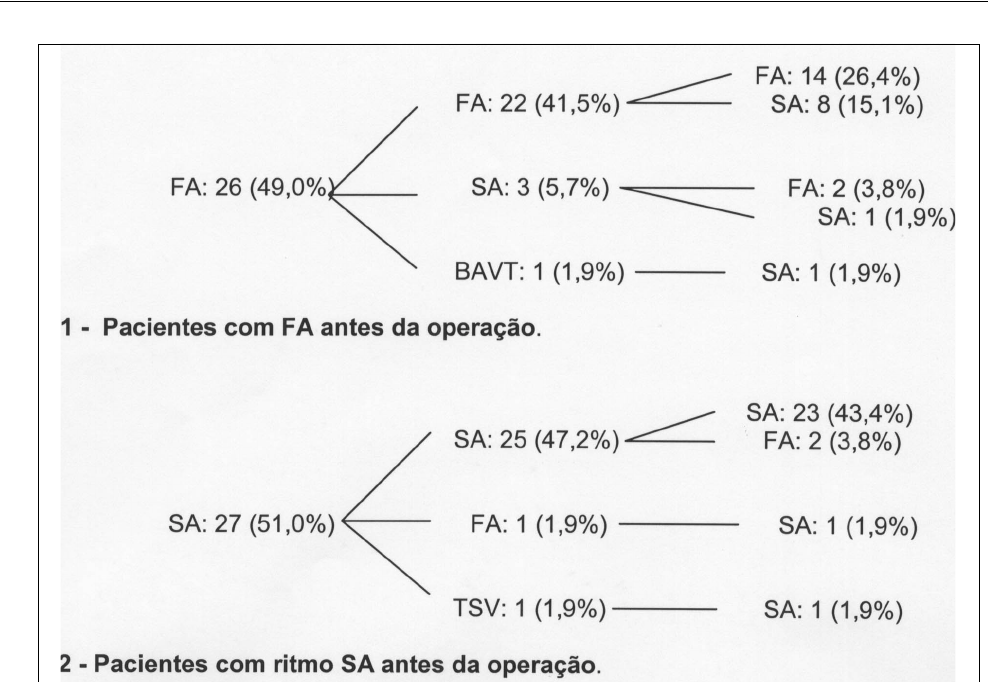
Fig. 1 - Evolução dos ritmos apresentados pelos pacientes. Acima (1), evolução dos pacientes com fibrilação atrial no período pré-operatório e abaixo (2), evolução dos pacientes com ritmo sinusal no período pré-operatório. Em ambos, o ritmo da coluna da esquerda é o pré-operatório, na coluna do meio está o ritmo pós-operatório intra-hospitalar e na coluna da direita, o ritmo pós-operatório tardio. FA: fibrilação atrial, SA: ritmo